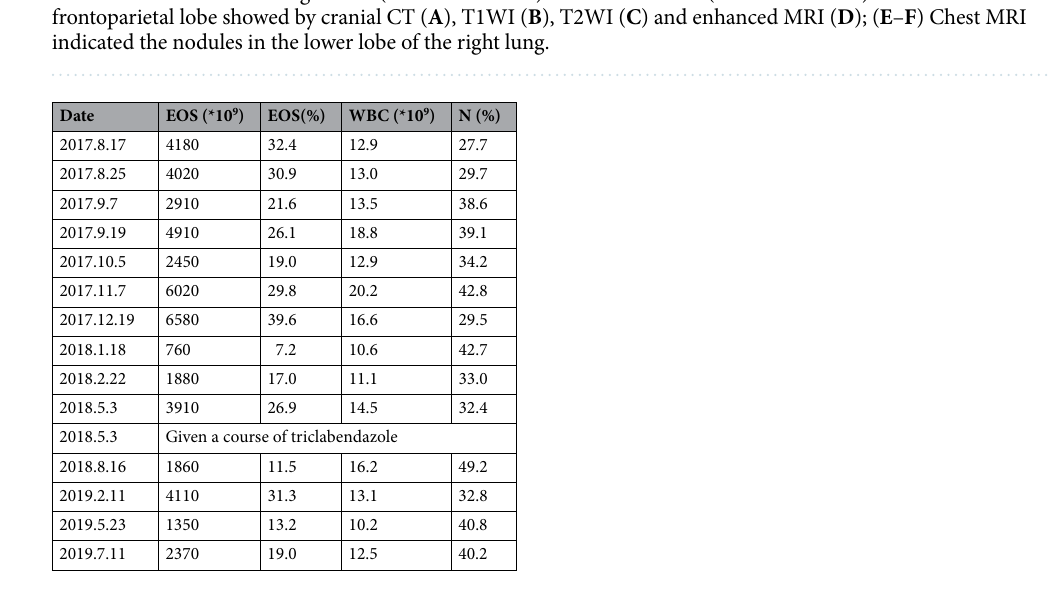
Table 4. Changes in peripheral blood of a patient with subcutaneous and penial nodules and eosinophilia after 3 courses of